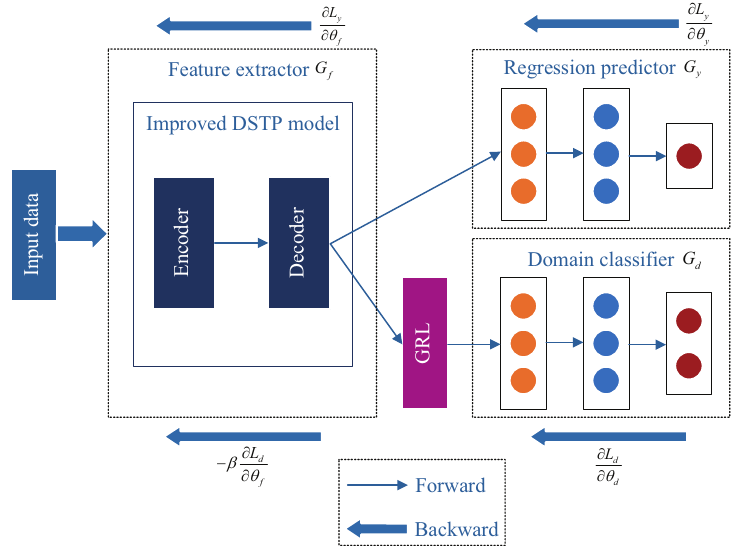
Figure 2. The proposed TL-DSTP-DANN structure. (1) Feature extractor: The feature extractor G f is used to extract the temporal and spatial features of the input time-series data. (2) Regression predictor: The purpose of the regression predictor G y is to find the mapping between the extracted spatial–temporal features and PM2.5 concentrations based on the source and the target domain data. (3) Domain classifier: The domain classifier G d distinguishes whether the extracted features come from the source or target